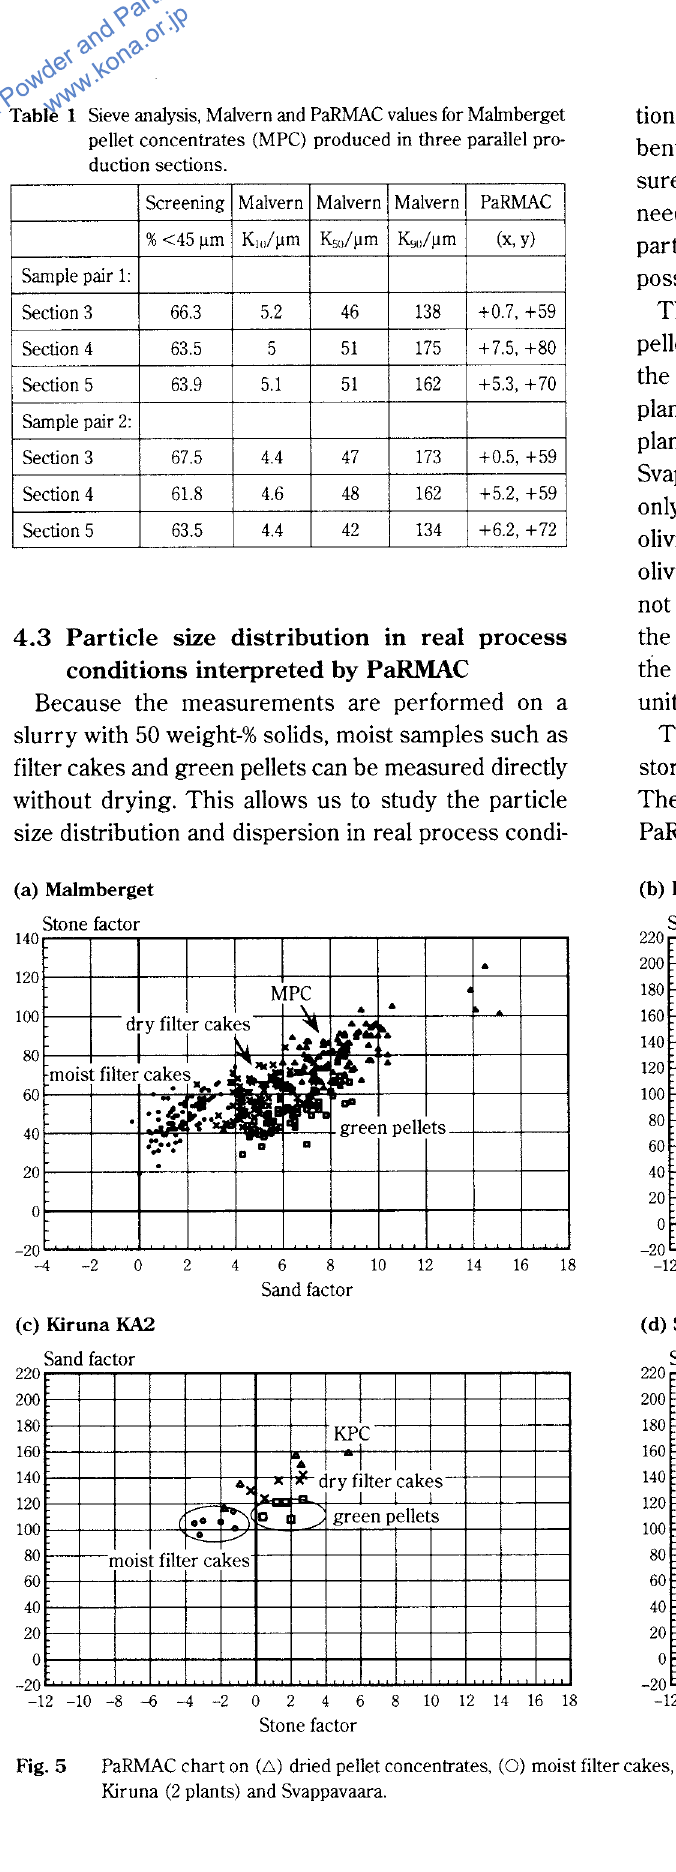
PaRMAC chart on (6) dried pellet concentrates. (0) moist filter cakes, (X) dry filter cakes and (D) green pellets at LKAB Malmberget, Kiruna (2 plants) and